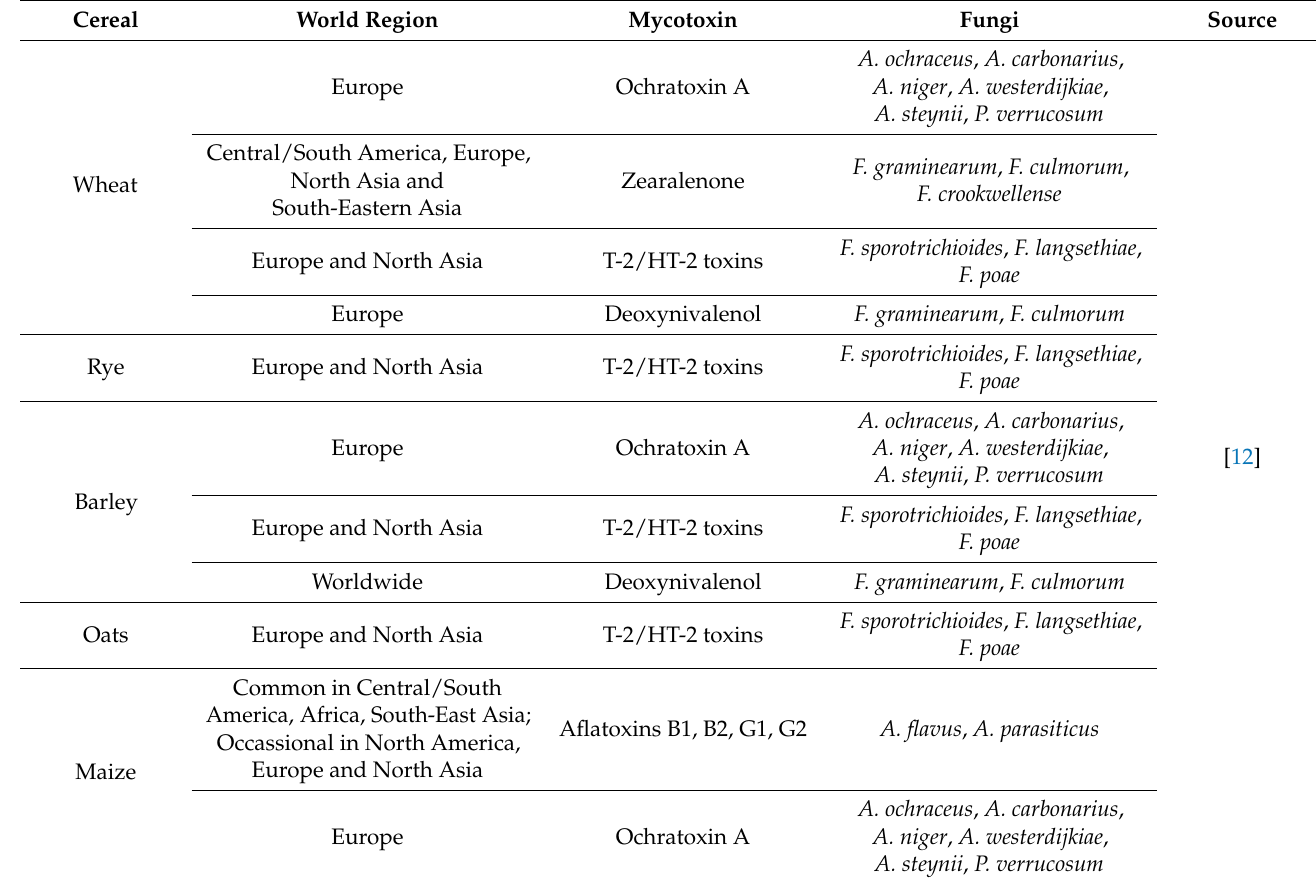
Table 1. Most common commodities, fungi, and mycotoxins